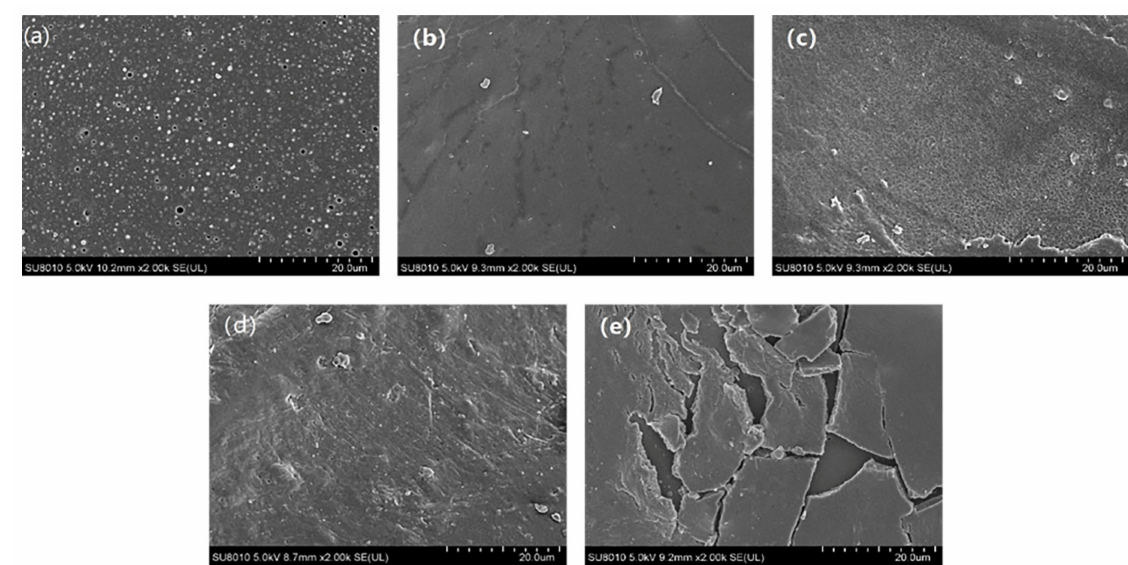
Figure 6. High magnification SEM images of OTS-CNTs/PU with different coupling times ( a ) pre-treated sponge, ( b ) 6 h, ( c ) 12 h, ( d ) 24 h, and ( e ) 48 h.